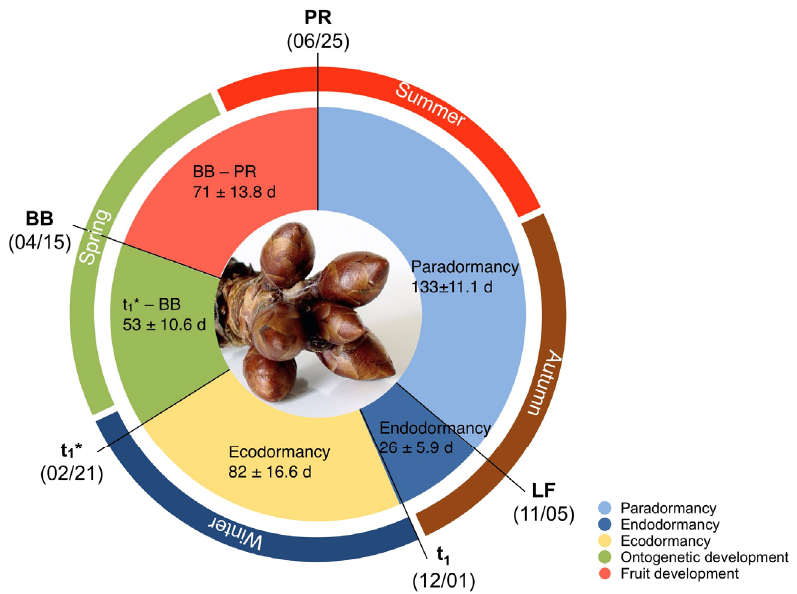
Figure 1. Average timing of phenological stages and duration of phenological phases of the sweet cherry cv. ‘Summit’ for 9 years (2011/12–2019/20) at the experimental orchard in Berlin-Dahlem. ‘Picking ripeness’ (PR), ‘total leaf fall’ (LF), endodormancy release (t 1 ), beginning of ontogenetic development (t 1 *), and ‘beginning of blossom’ (BB, BBCH 61). Numbers in the inner circle give the length of phases ± standard deviation in days (d). Extended data from [17].